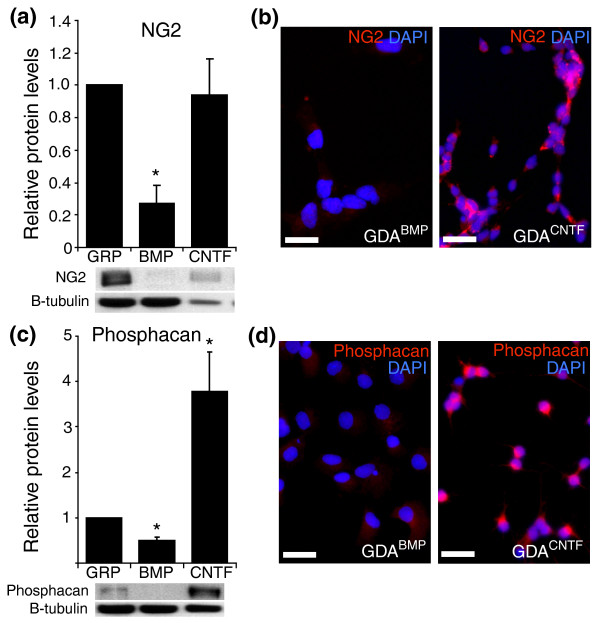
GDAsBMP, GDAsCNTF and GRPs express different levels of NG2 and phosphacan in vitro. GRPs were induced to differentiate into astrocytes by exposure to BMP or CNTF. Relative levels of expression of NG2 and phosphacan proteins were determined by quantitative Western blot and immunocytochemical analysis. (a,c) Western blot analysis of whole-cell lysates demonstrates that GDAsCNTF express higher levels of (a) NG2 and (c) phosphacan. The graph shows fold change in protein levels for GDAs compared to GRPs. Error bars represent 1 standard deviation (SD). *p < 0.05. (b,d) Immunofluorescent labeling of cells using (b) anti-NG2 antibodies and (d) anti-phosphacan. Scale bars 50 μm.